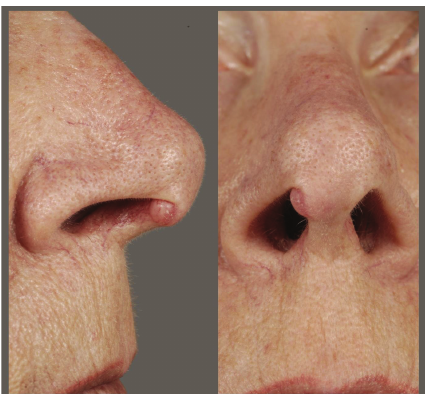
Figure1:Clinicalfindings:atumormeasuringabouteightmillimeterslocatedontheupperborderoftherightnostril.Therewasanadditional subcutaneous expansion towards the tip of the nose and the columella. The lesion was hemispherical, immobile, sharply demarcated, nonirritated, and painless.